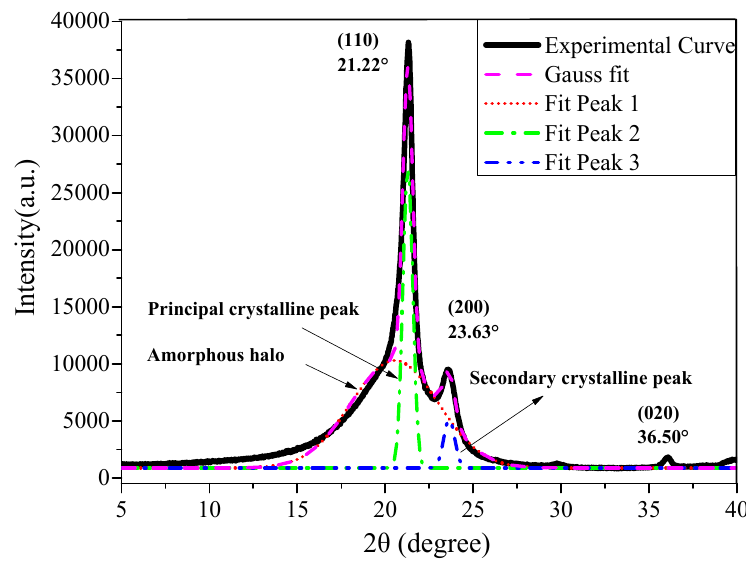
Figure 11. Gaussian fitting of the crystalline peaks and the amorphous halo by the Hinrichsen method.